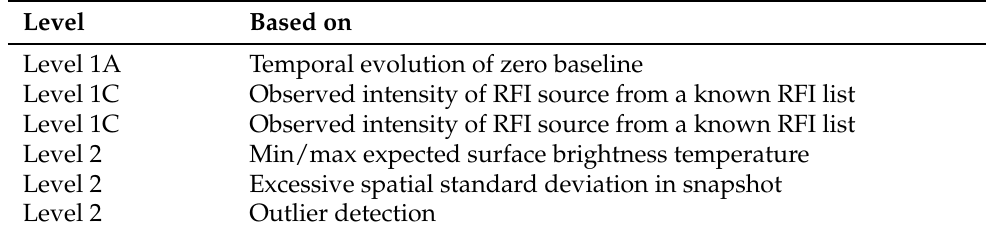
Table 1. Combined RFI detection strategy by the SMOS